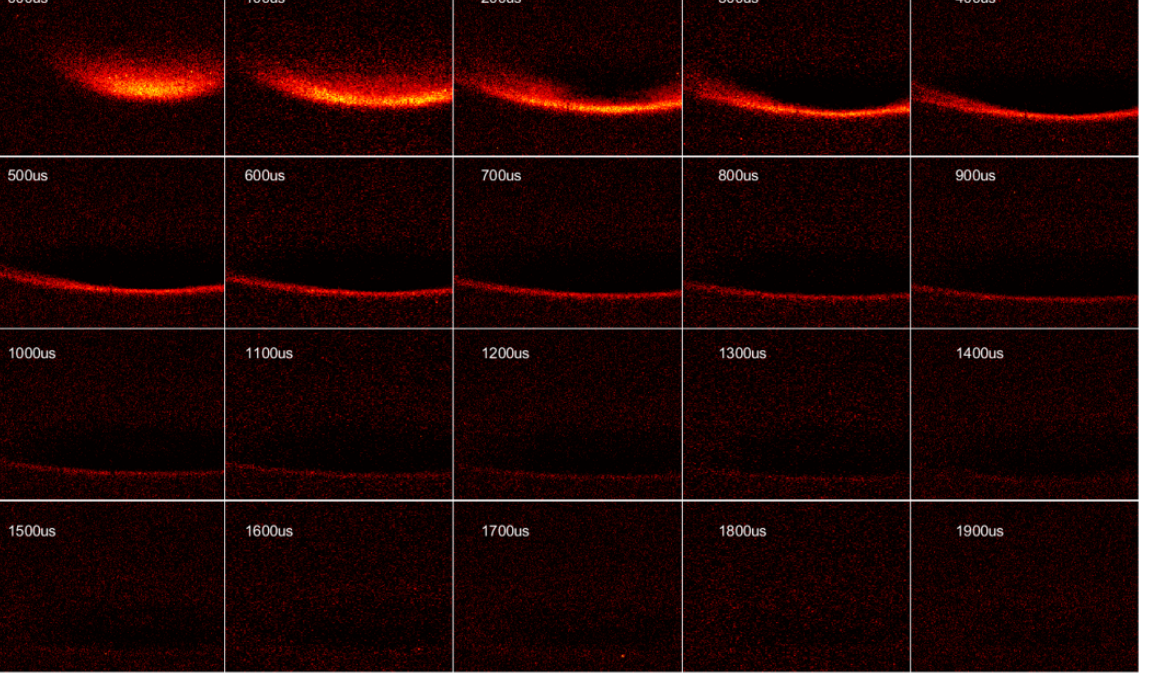
Figure 5. The differential images between frames in Figure 4 to reproduce the nearly-real time of elves images. For reconstructing the donut structure of the elves emission, we integrated 20 high- speed camera-recorded frames, each with each a duration 100 us, which equals a total time of 2 ms. Figure 6 shows the reconstructed results between 10,000 fps and 30 fps image frames of the simultaneously recorded elve emission. Figure 6a indicates the first 2 ms time-integrated image from the high-speed camera frame sequence at time resolution 100